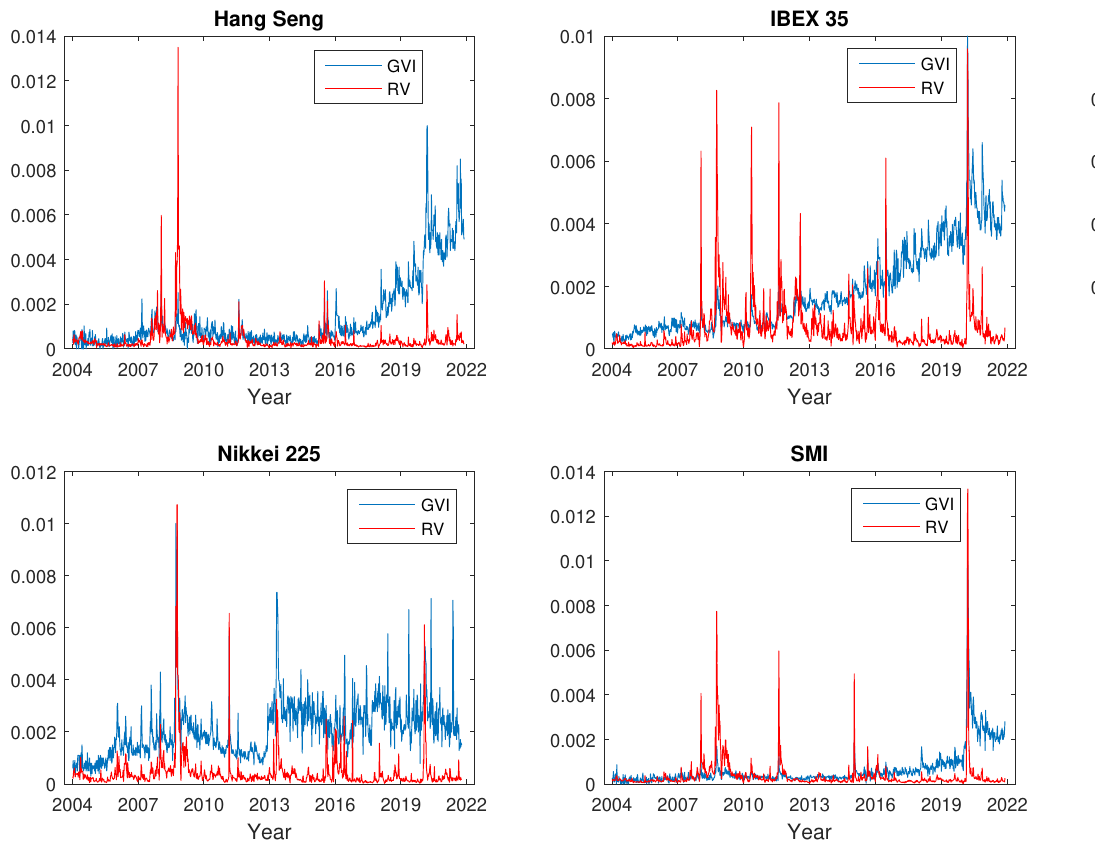
Figure 1. Weekly RV and GVI. For comparability, the GVI data were scaled by 10 − 4